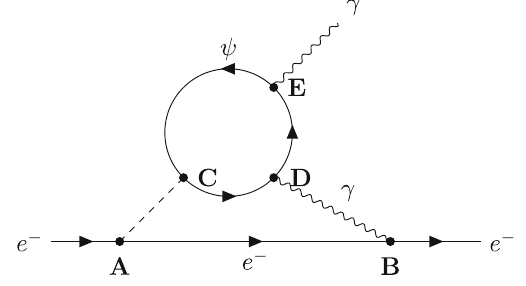
Fig. 2 Two-loop Barr–Zee diagram for the electron